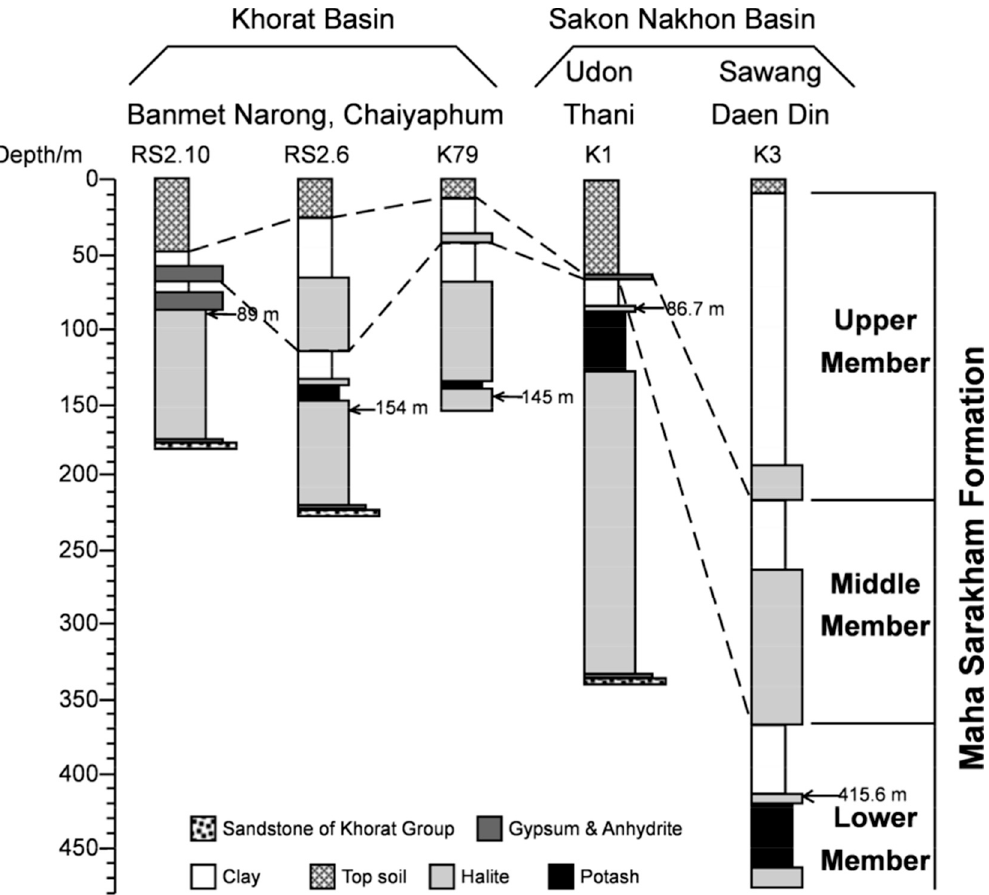
Figure 2. Stratigraphy of the Cretaceous Maha Sarakham Formation in cores RS2.10, RS2.6, K79, K1, and K3. Core K3 contains the complete sequence (Lower, Middle, and Upper Members). Each Member contains evaporites overlain by siliciclastic redbeds. The Middle and Upper Members are missing or incomplete in the other cores, most likely due to post-depositional dissolution [30].